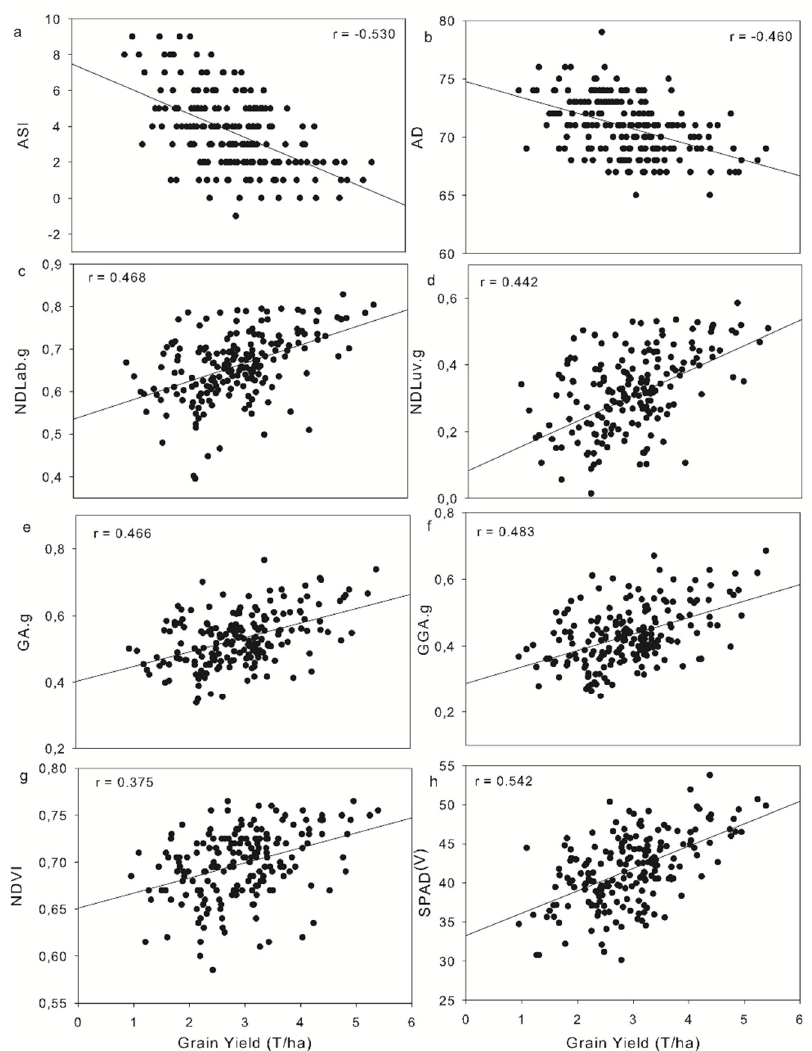
Figure 7. Correlation between GY in LOW and ( a , b ) traditional field plant physiology measurements ASI and AD; ground RGB VIs ( c ) NDLab; ( d ) NDLuv; ( e ) GA.g (green area ground); ( f ) GGA.g (greener green area ground); ( g ) plant vigor using GreenSeeker NDVI; and ( h ) relative leaf chlorophyll content in the vegetative stage (SPAD V ). Level of significance: ***, P < 0.001. (n = 192). Table 6. Multilinear regressions (stepwise) of GY in LOW as the dependent variable comparing the different categories of remote sensing traits: UAV and ground RGB VIs (these indices are defined in Section 1), agronomic data such as ASI, AD, SEN, and PH, and NDVI and SPAD. R 2 , determination coefficient; RSE, Residual Standard Error. Level of significance: ***, P < 0.001. (*) simplified formulas.